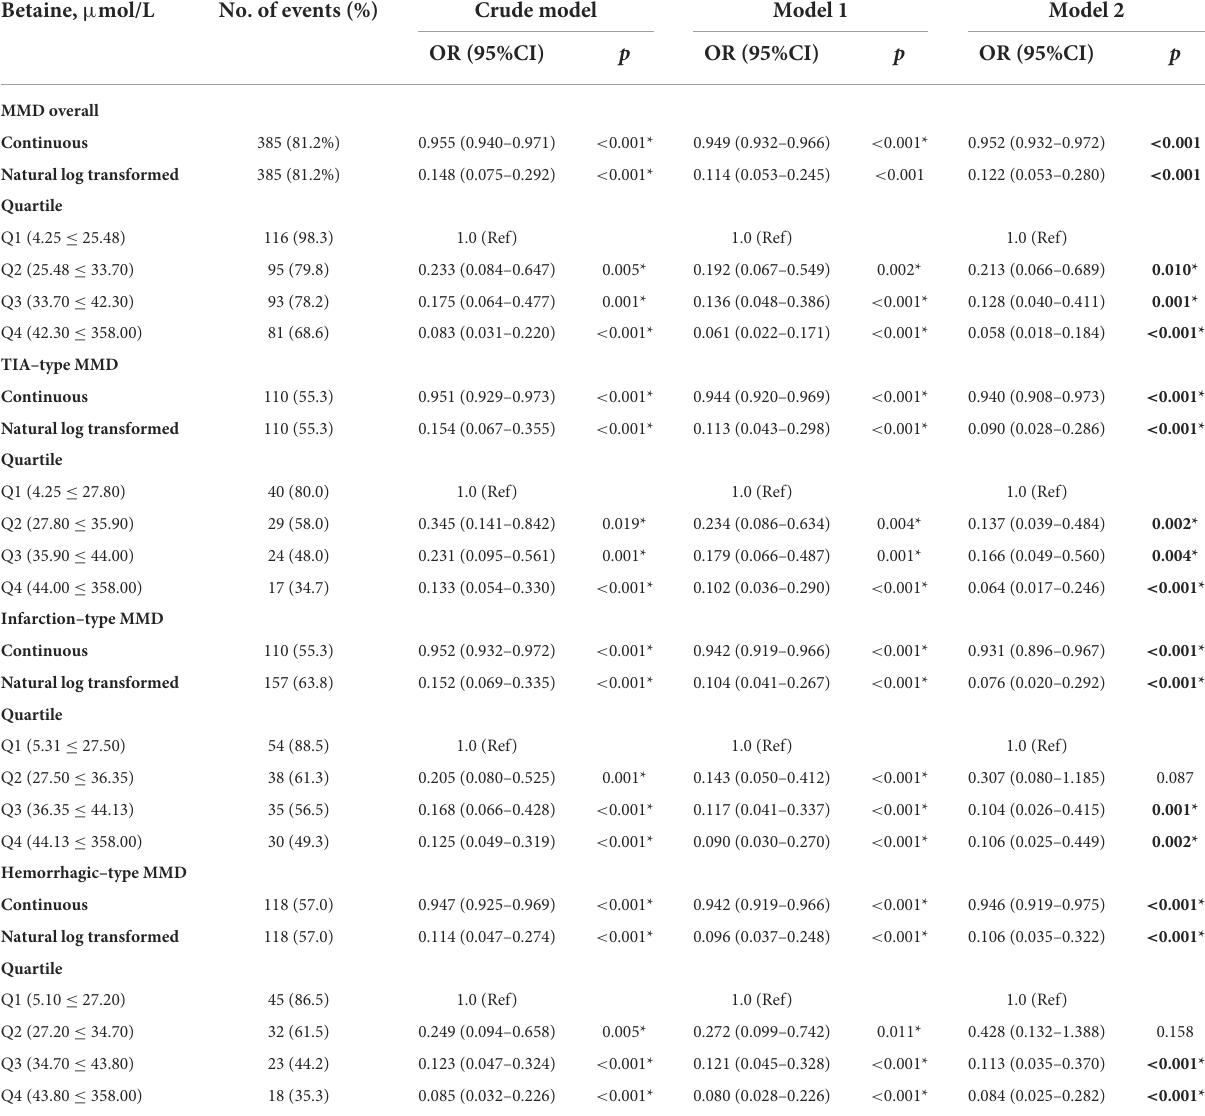
Crudemodel:unadjustedlogisticregressionmodel;Model1:adjustedforage,sex,heartrate,SBP,DBP,andBMI;Model2:furtheradjustedforWBCcount,lymphocytecount,neutrophil count,plateletcount,albumin,creatinineuricacid,triglyceride,totalcholesterol,HDLcholesterol,LDLcholesterol,ApoA,ApoB,homocysteine,andeGFR. *p <